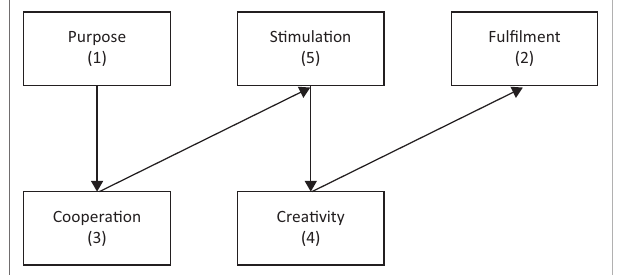
FIGURE 1: Uncluttered linear system influence